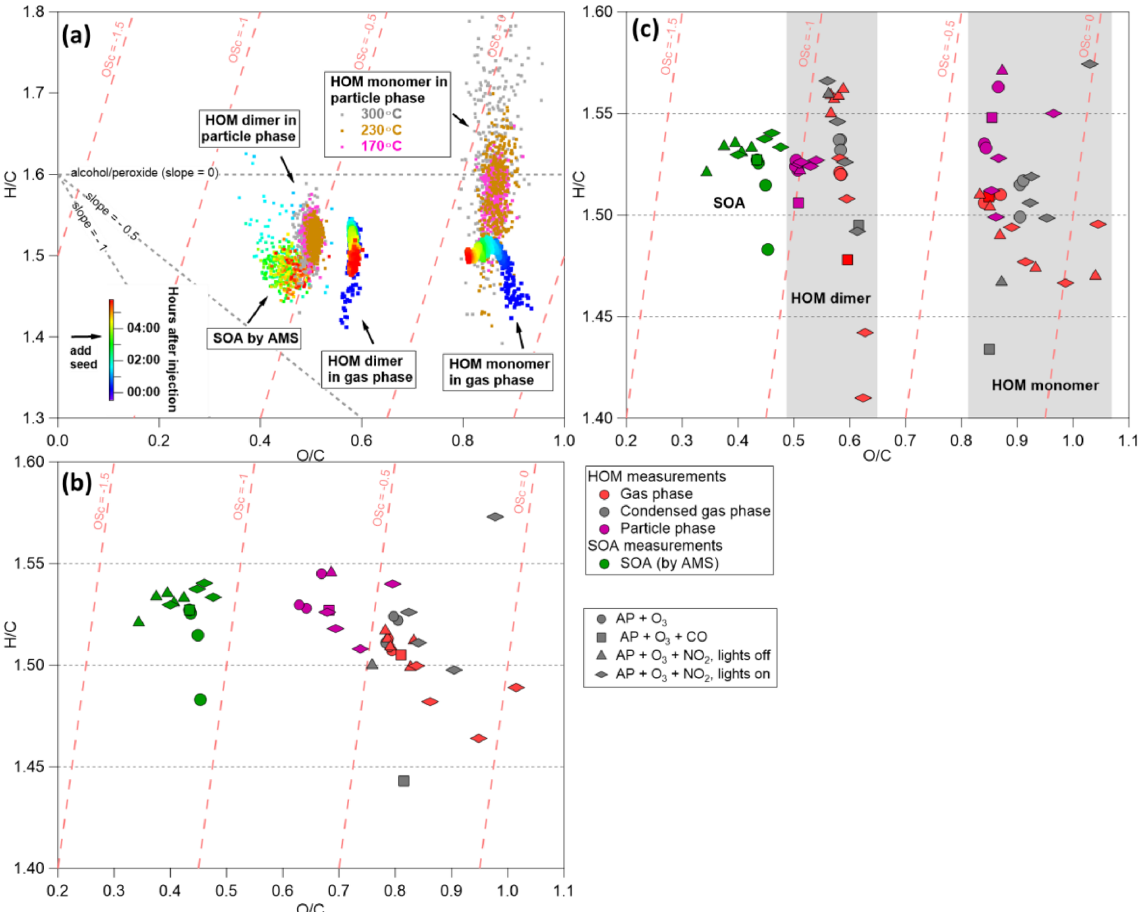
Figure 9. The van Krevelen diagrams of the VIA–NO 3 -CIMS and AMS data. (a) Gas-phase HOMs (10s averaged data points) and SOA measured by AMS (20s averaged data points) from experiment no. 1. The SOA and the gas-phase HOM data are colored by the time after α -pinene and O 3 injection, while the particle-phase HOMs are colored by the temperature of the VIA. (b) Average “bulk” HOM and SOA elemental ratios for all experiments. (c) Average gas-phase (red, 30min), condensed-gas-phase (grey, 30min), and particle-phase (purple, 60min) HOM elemental ratio separated into monomers (C 8 –C 10 ) and dimers (C 16 –C 20